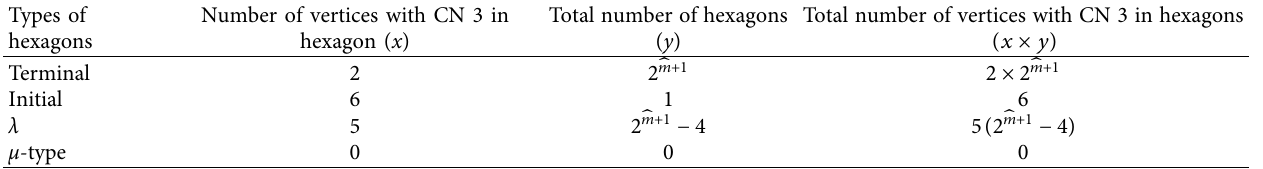
Table 1: Total number of vertices with CN 3 in ζ .